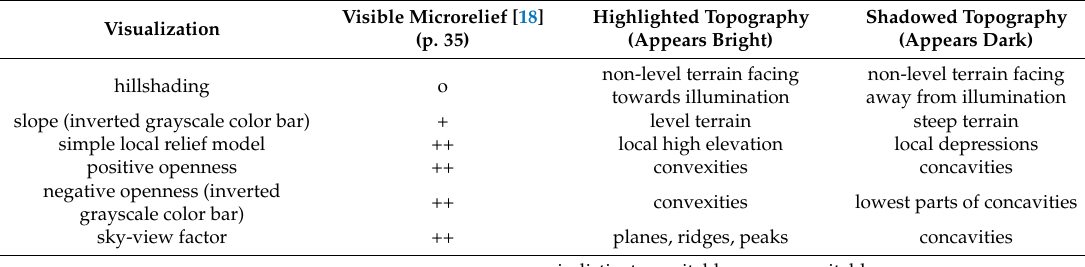
Table 1. Display characteristics of grayscale